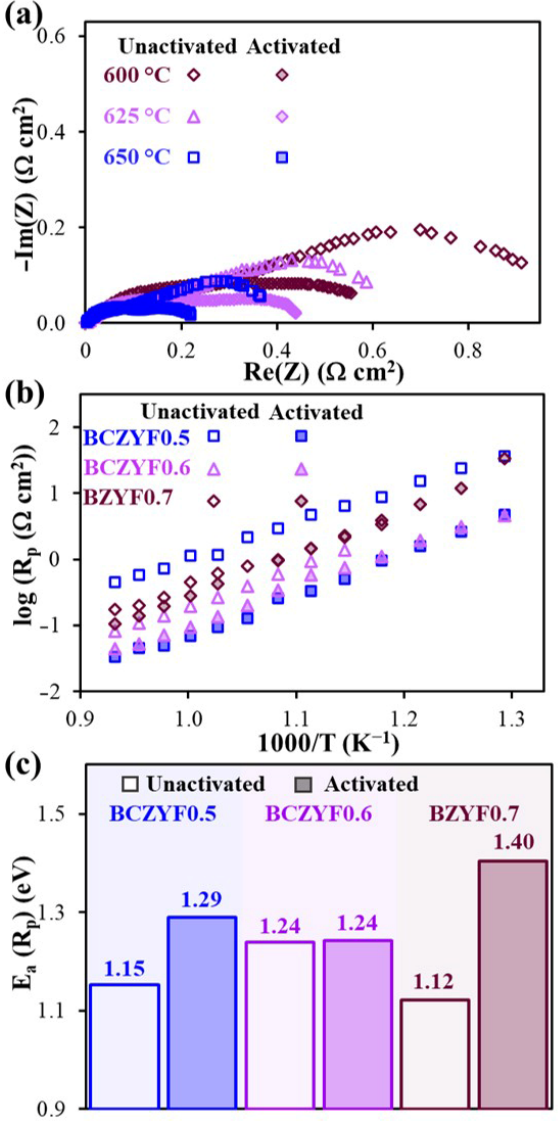
Figure 5. Electrochemical results obtained for the SDCs with the origin (unactivated) and electroactivated BCZYFx electrodes: (a) impedance spectra for BCZYF0.6 at various temperatures, (b) temperature dependences of polarization resistances, and (c) the apparent activation energies.